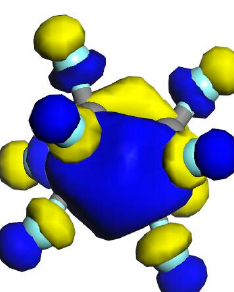
Figure 8. c-C 4 F 8 molecular orbital distribution.